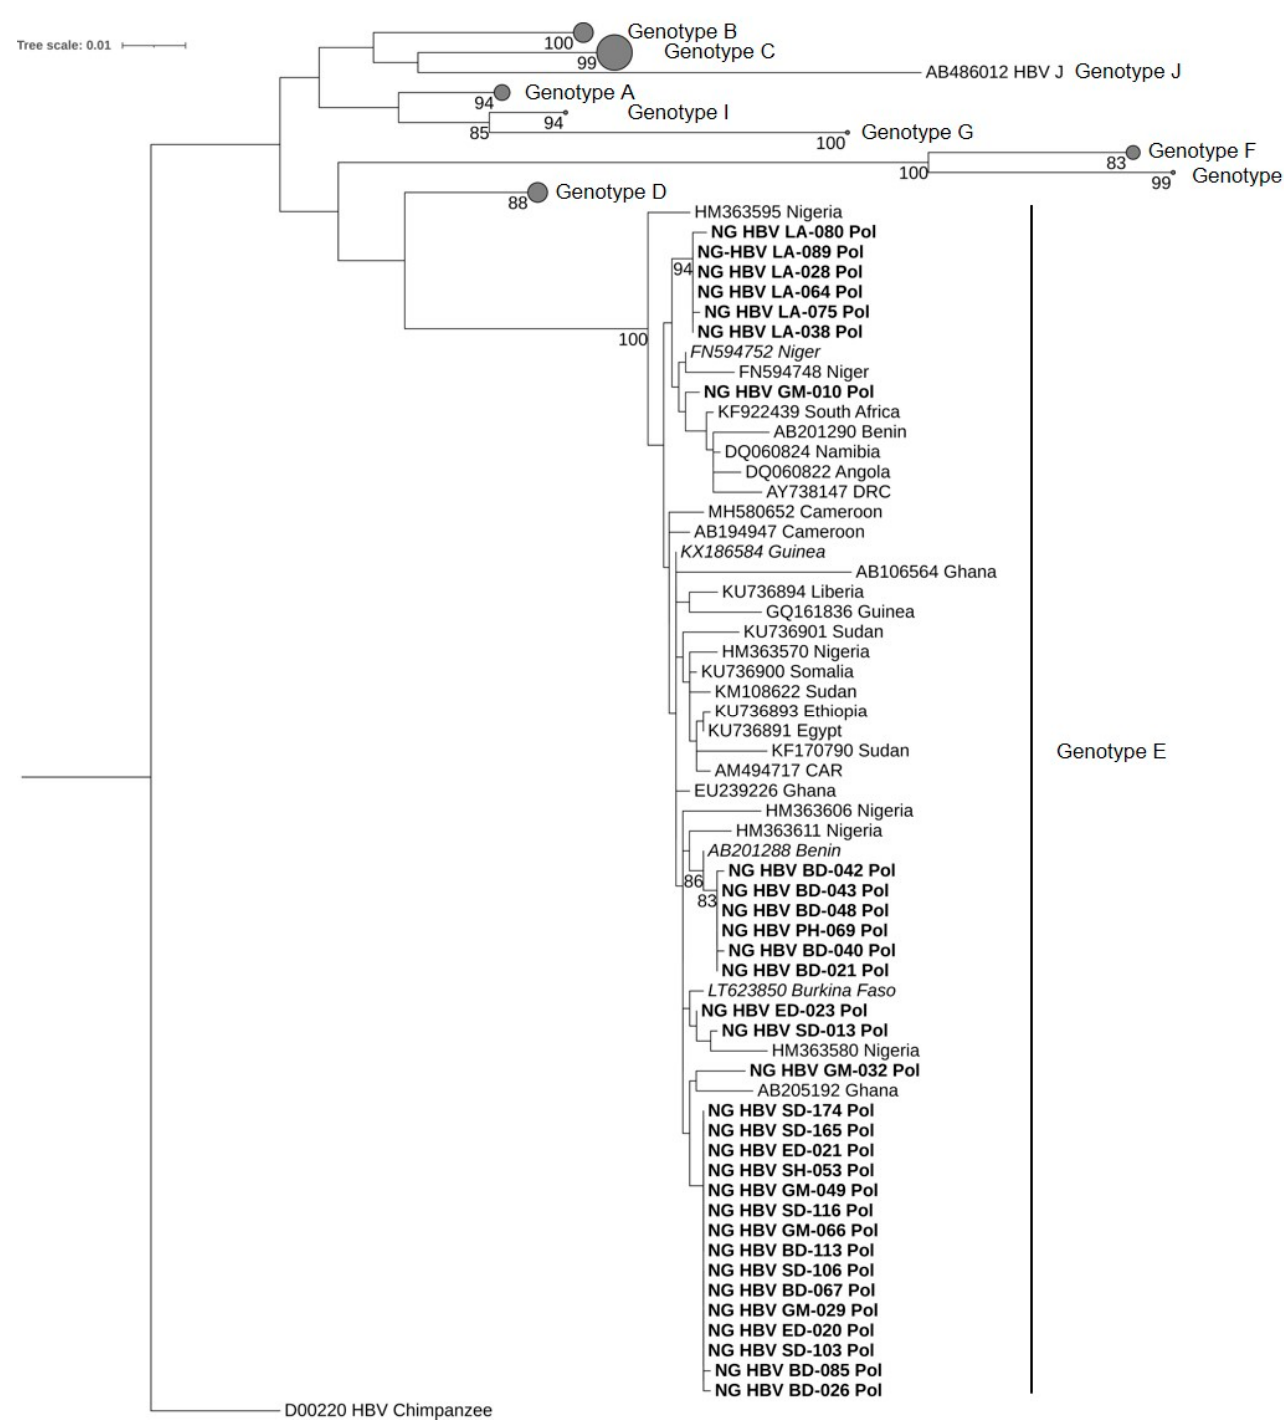
Figure 2. Phylogenetic analysis inferred using the maximum likelihood method based on the TIMe-+I+G4 model recon- structed from a 1014-bp-long fragment of the partial HBV Pol gene region. All 31 sequences obtained from this study were assessed as genotype E. The HBV sequences from this study are indicated in bold, whereas the best BLASTn matches are indicated in italics. HBV reference genomes of genotypes A–D and F–J are collapsed, with the size of the gray circles being proportional to the number of reference sequences. Bootstrap values >75% are indicated.